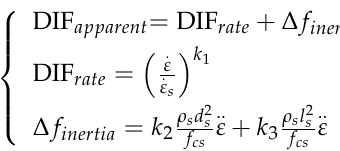
( b ) Figure 2. Specimens for SHPB test: ( a ) Mortar, ( b ) Concrete. A quasi-static test was conducted before the dynamic load test. An RMT-150B multi- functional full-automatic rigid rock servo testing machine was used for the static load test. The specimen radius and height were 50 and 100 mm, respectively. There were 3 test